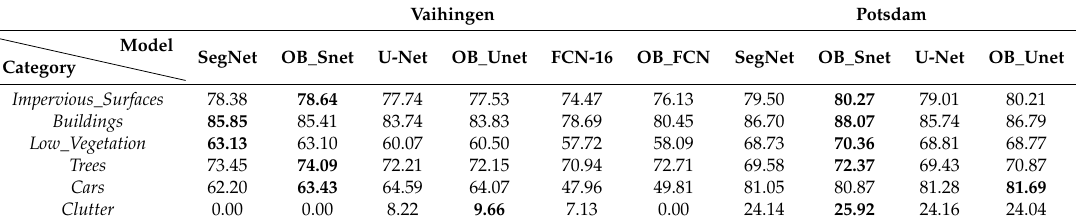
Table 3. Intersection-over-Union (IoU) results for the Vaihingen ( left ) and Potsdam ( right ) datasets. The overall IoU value for each semantic category is calculated by adding the IoUs of all the testing images and dividing by their